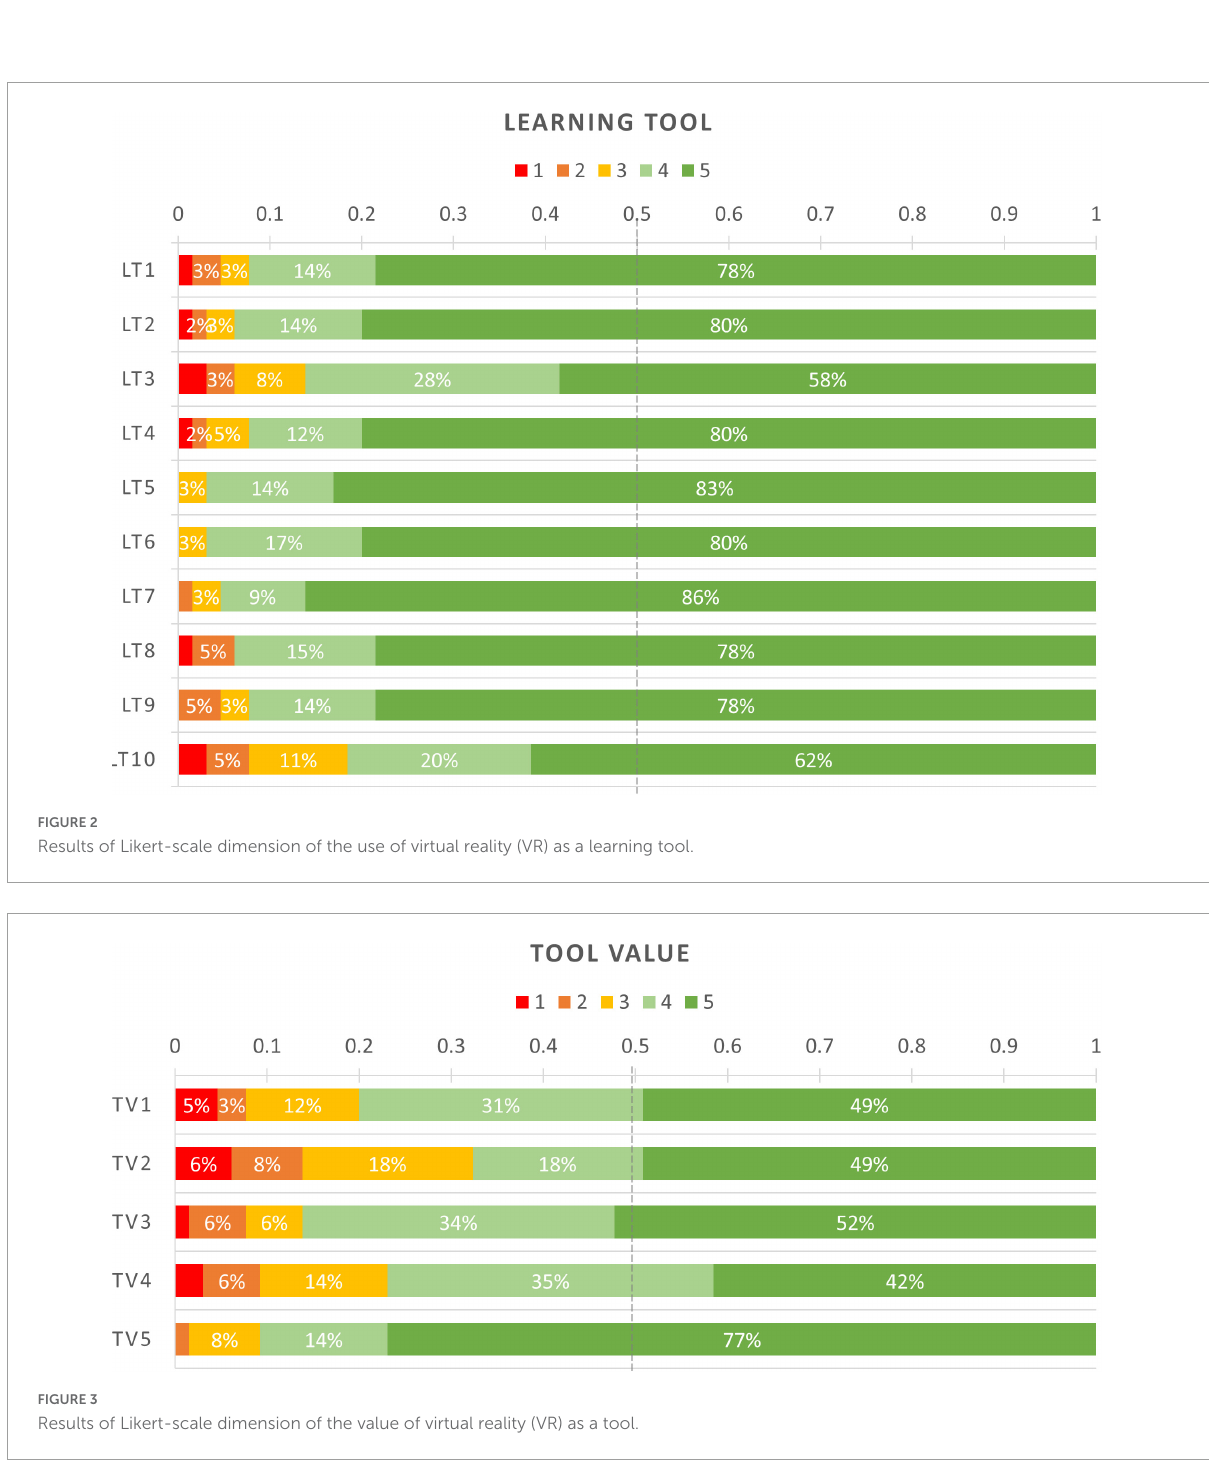
toward their grades. Over 65% of students agreed that